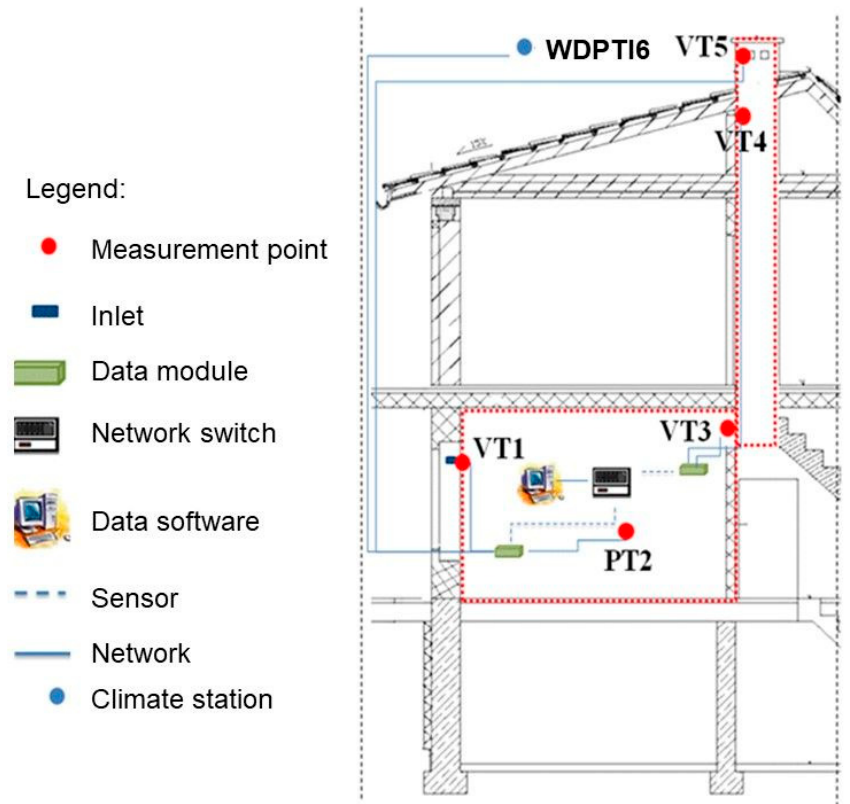
Figure 6. The measurement system in the test building.